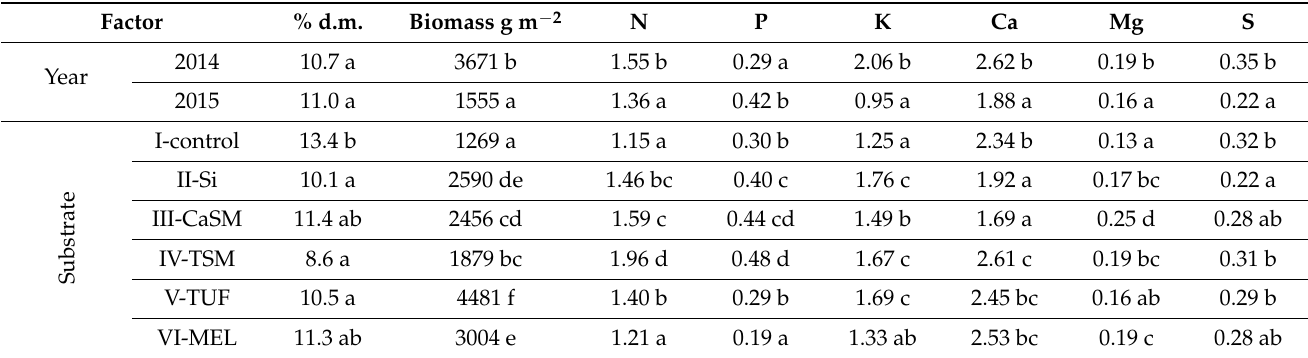
Table 9. Dry matter (%) and biomass (g m − 2 ), and macroelements content (% d.m.) in Sedum acre L. grown on six green roof substrates.